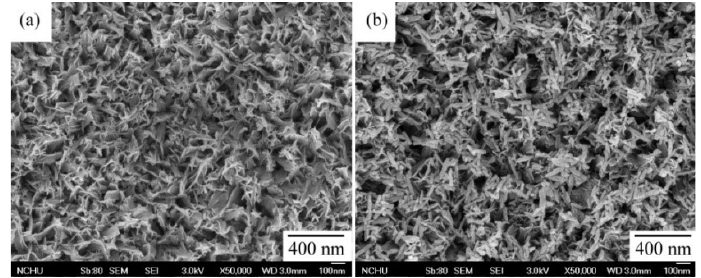
Figure 5. FE-SEM images showing the effect of ultrasonic cleaning on the surface morphology of HA- coated c.p. Ti samples after hydrothermal treatment at 150 °C for 48 h: non-heat-treated surface ( a ) and heat-treated surface at 500 °C for 2 h ( b ).